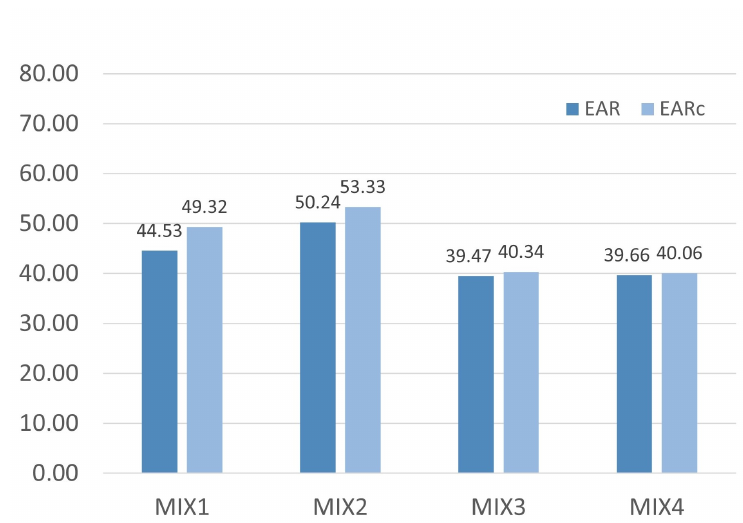
Figure 3. Comparison of EAR and EAR c values evaluated for the four reference